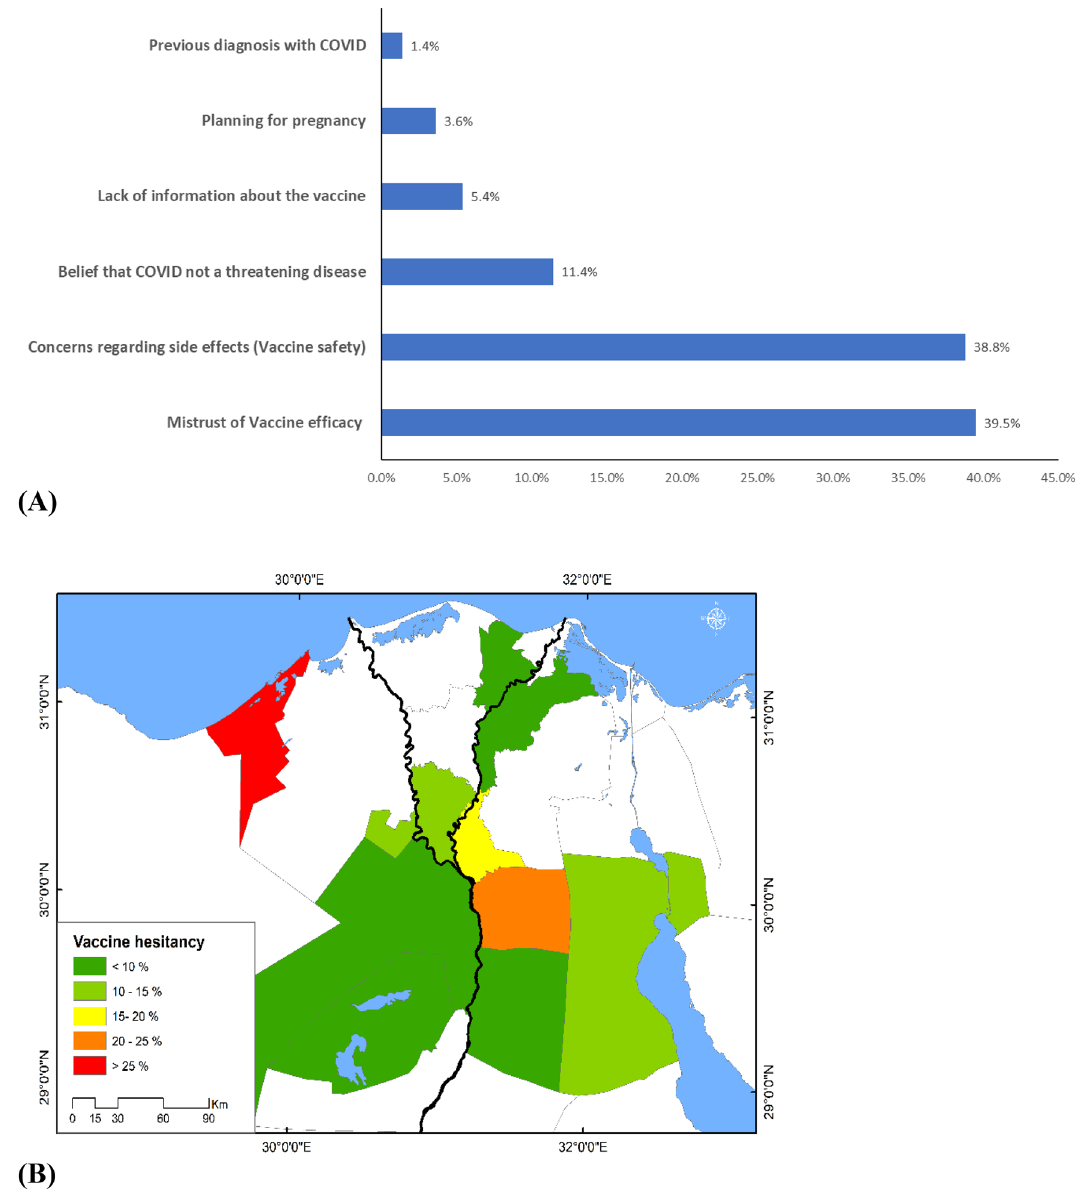
Figure 5. ( A ) Causes of vaccine refusal ( B ) Proportion of individuals who refused to receive COVID-19 vaccination across different